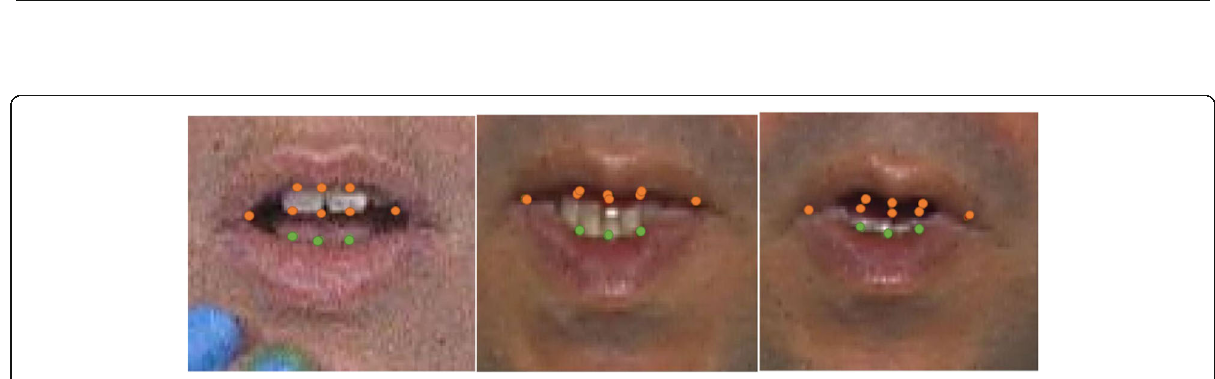
Fig. 13 a Speaker ’ s lips with CLNF original landmarks (note that two red endpoints of the inner lips contour are mistakenly placed). b Six center points are plotted with red stars which are dilated in the vertical scale to form a square in polar coordinates. c The vertical axis presents the ρ value and the horizon axis θ . The six points are repeated three times. d Periodical spline interpolation is realized, and only the period inside two red lines is used to return to Cartesian coordinates. e The whole interpolated inner lips contour